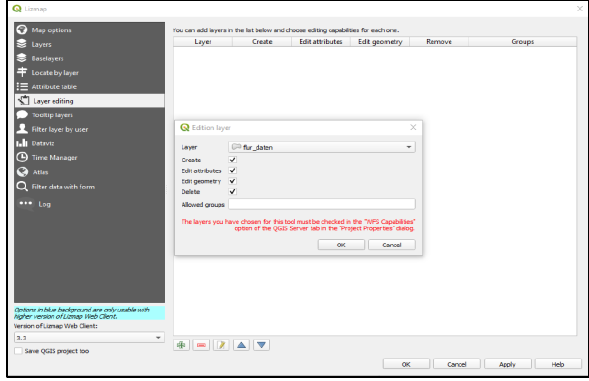
Figure 8 : Activation of “Layer editing” in Lizmap plugin.